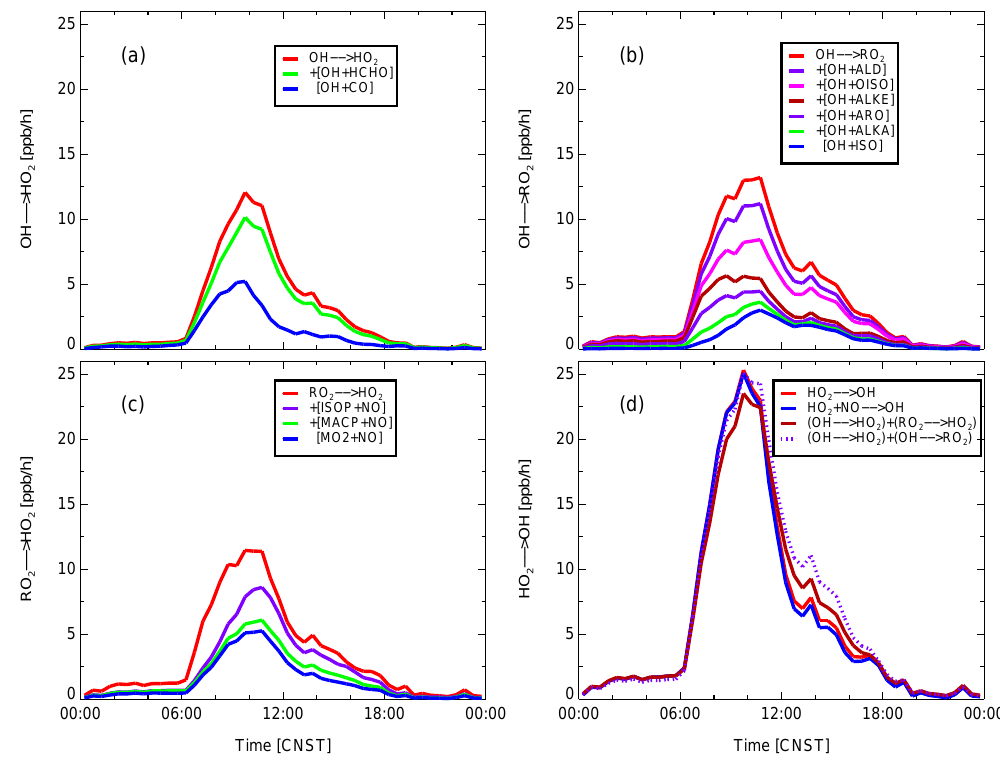
Fig. 7. Radical conversion rates (red − ) of (a) OH → HO 2 , (b) OH → RO 2 , (c) RO 2 → HO 2 , and (d) HO 2 → OH, calculated with RACM-MIM-GK (M0). The cumulative contributions of dominating reactions are presented as explained in Fig. 6. Panel (d) : total OH loss and total HO 2 production, both confined to radical conversion reactions, are displayed by the dotted violet and solid brown lines, respectively.